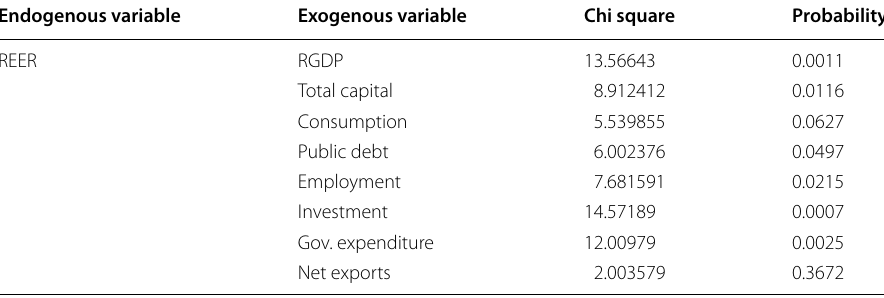
Table 14 Wald test results for Eq. (10). Source : Author’s